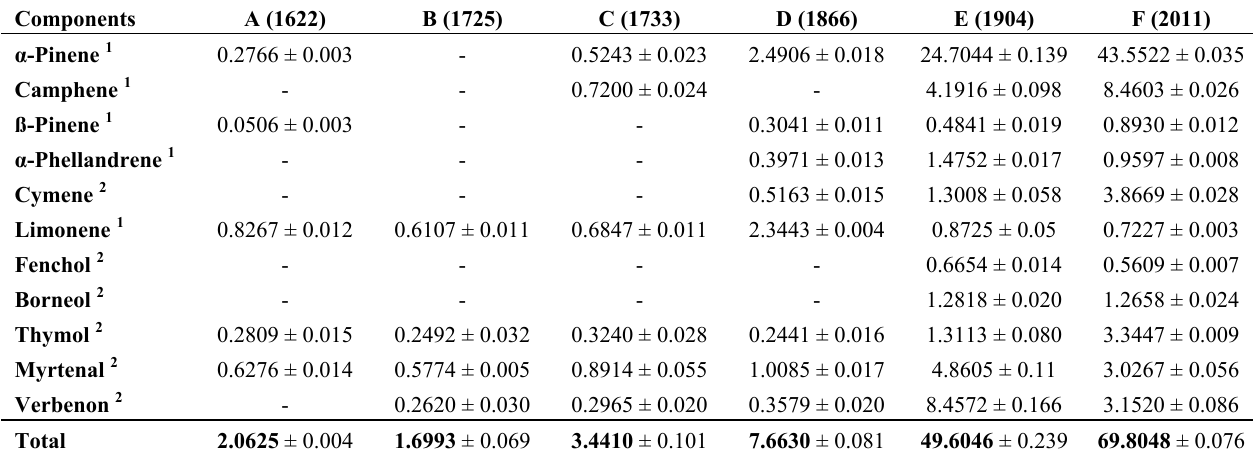
Table 2. Quantities of terpenes in samples of treated wood at the temperature of 60 °C (mg/kg). Components